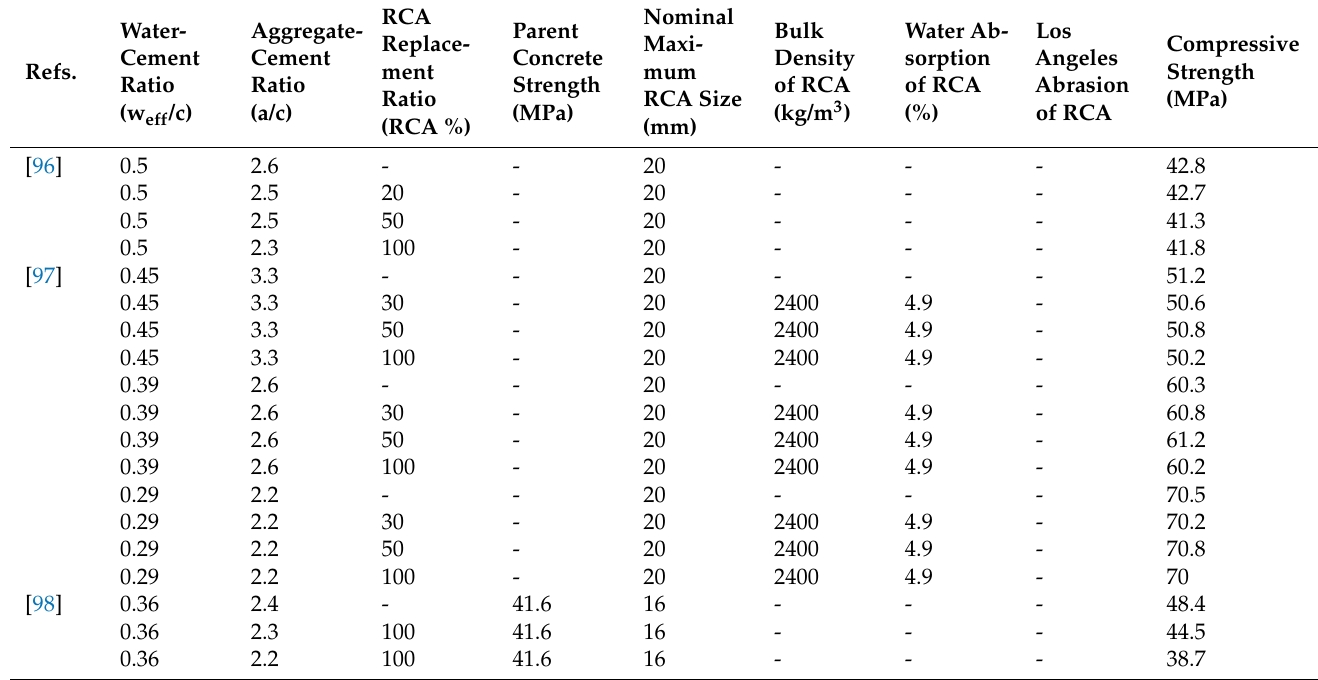
Table A1. Data set retrieved from the literature and used for the